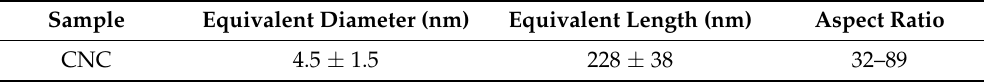
Table 1. The properties of CNC from kenaf